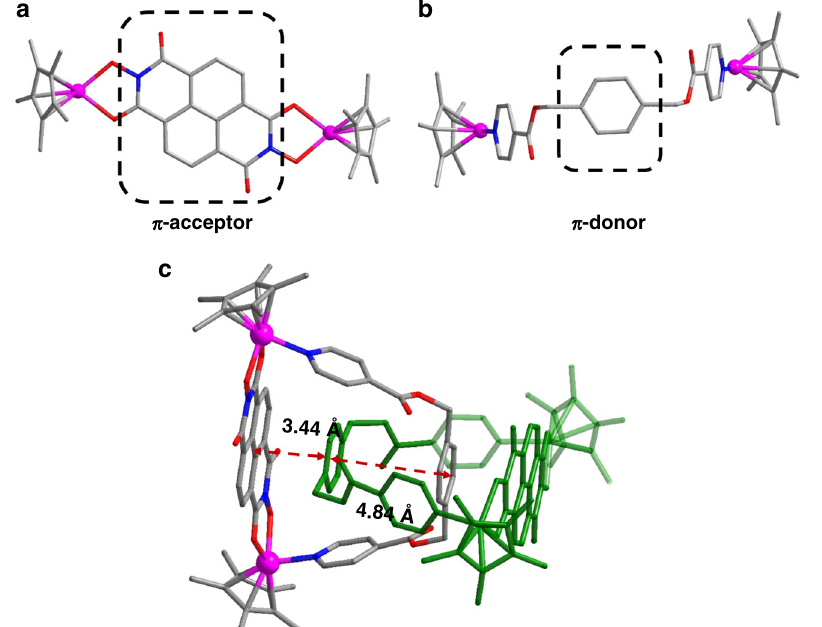
Fig. 9 X-ray structure of 5 ([2]catenane). a , b depictions of the short and long arms (N, blue; O, red; C, gray; Rh, purple) ( c ) ball-and-stick representations. Counteranions are omitted for